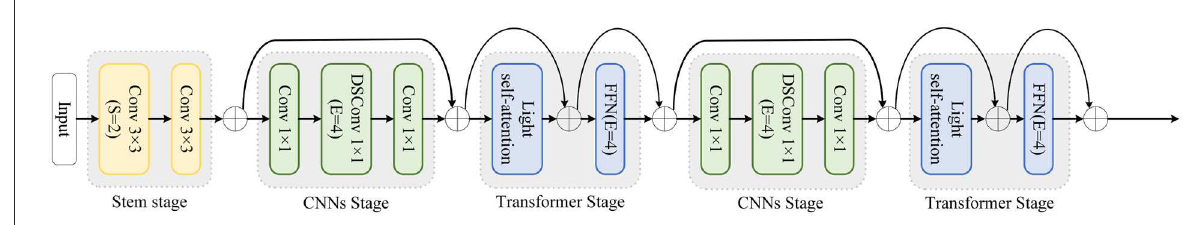
FIGURE2 The proposed hybrid network consisting of CNNs stages and Transformer stage.